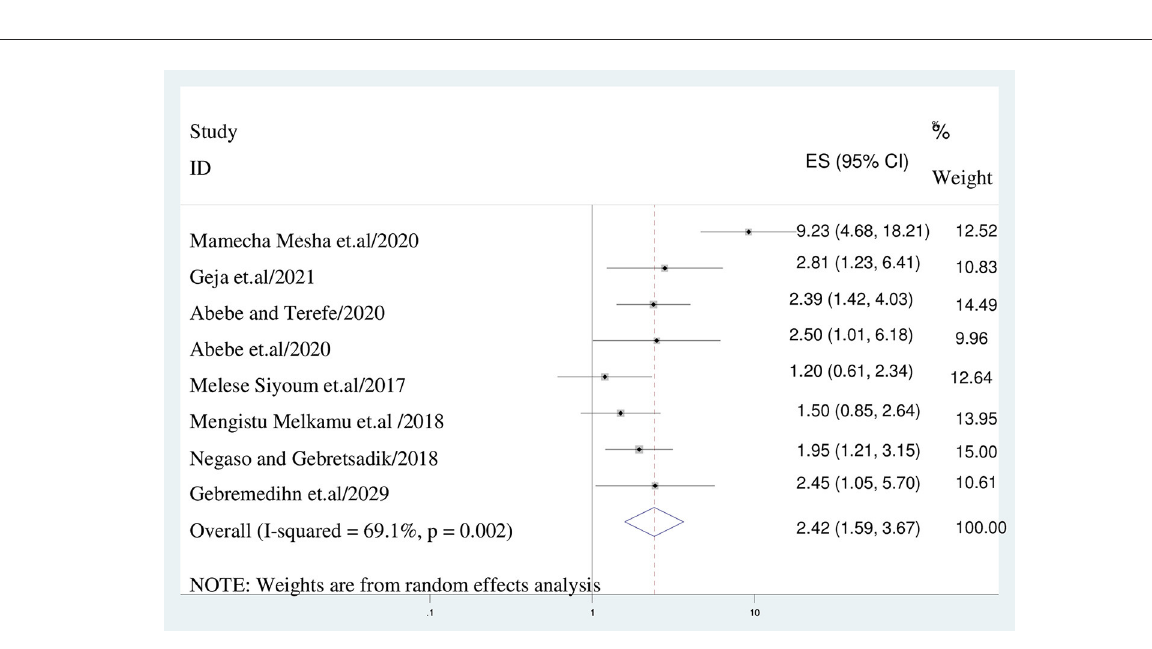
The discontinuation rates of institutional-based studies (47.9%) are greater than those of community-based studies (25.9%). It could be because mothers in institutional based research are sufficiently informed of their right to discontinue a method if they get pregnant or unsatisfied